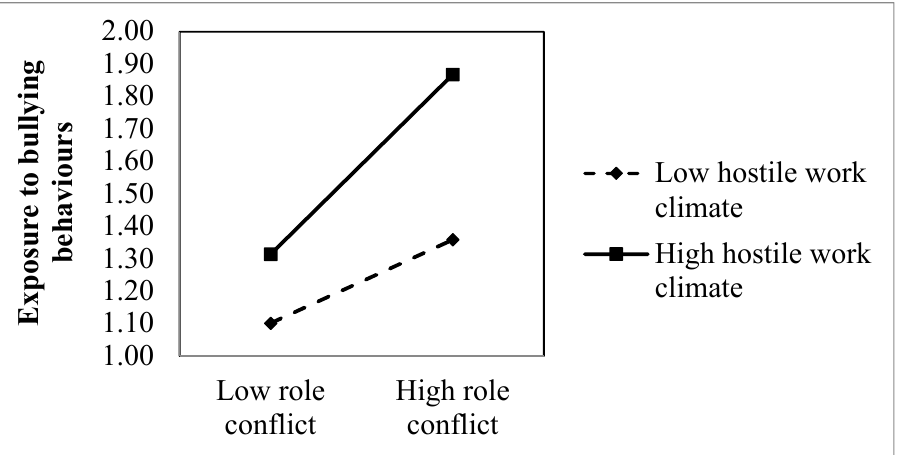
Figure 1. Plot of the interactive relationship of role conflict and bullying behaviours in departments with weak vs. a strong hostile work climate.